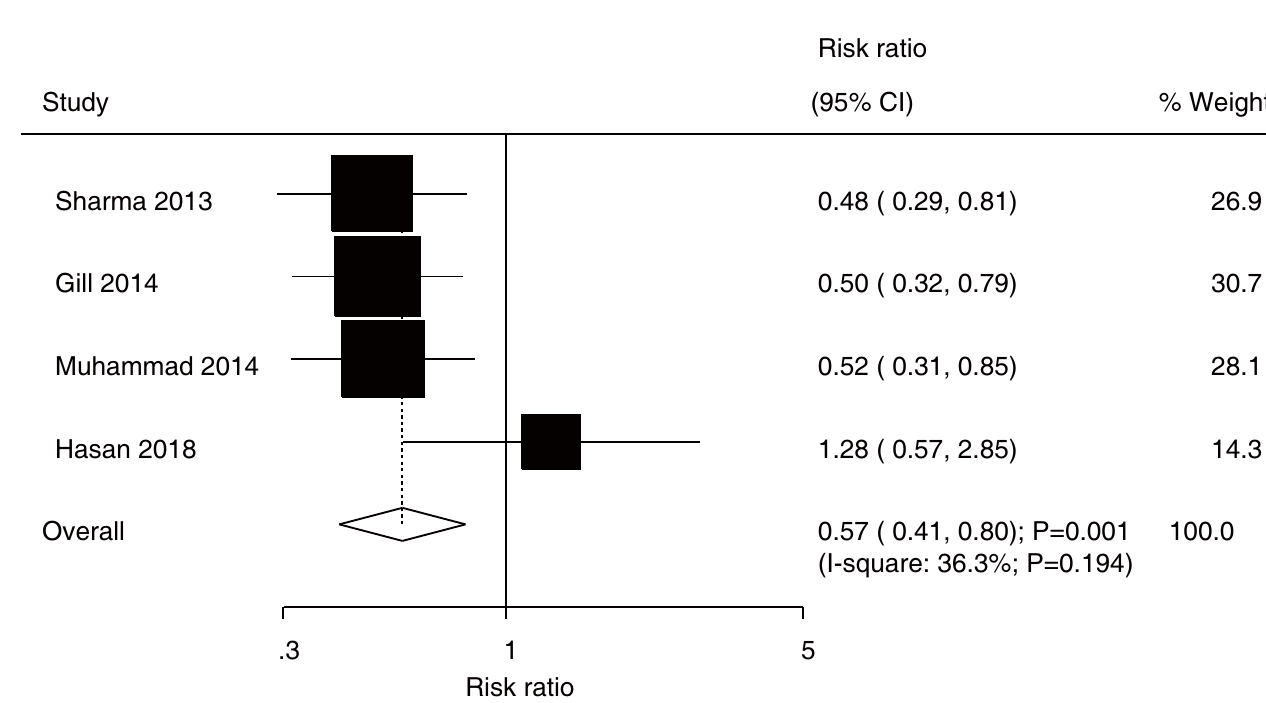
Fig 3. Effect of rifaximin plus lactulose versus lactulose alone on the risk of mortality.